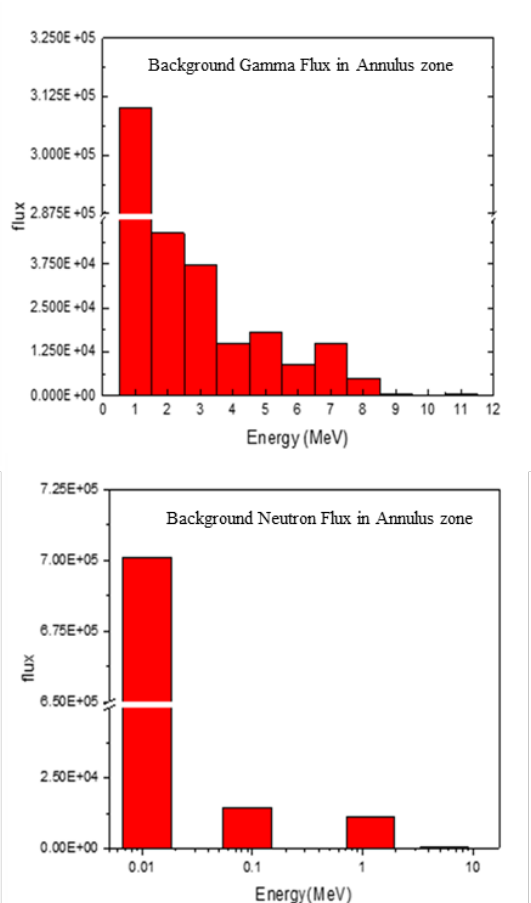
Fig. 1. The background radiation in an annulus zone of a nuclear power plant (top) gamma (bottom) neutron